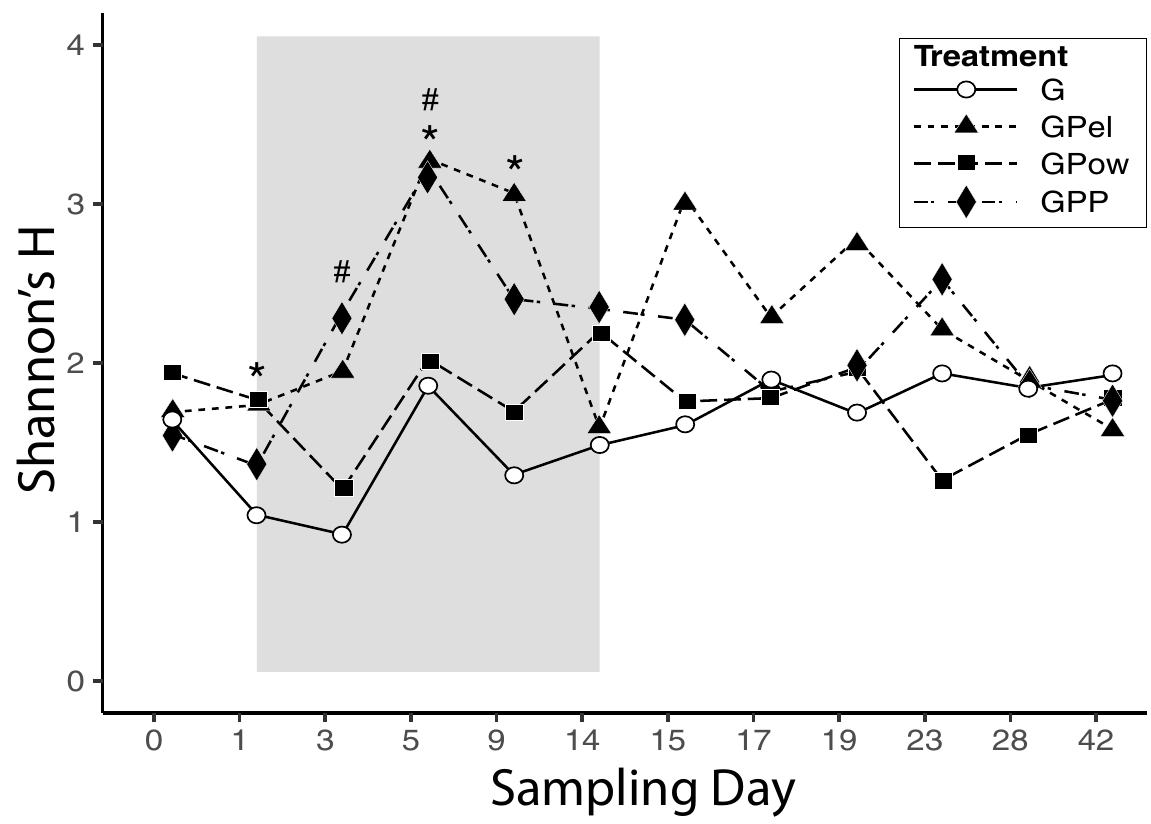
Fig 4. Bacterial diversity (Shannon Diversity Index) in fecal samples collected over 42 days from domesticated pigeons exposed to different diets. Shaded area represents treatment period, and treatments consisted of Grain (G), Grain + Probiotic Powder (GPow), Grain + Probiotic Pellet (GPel), and Grain + Probiotic Pellet + Probiotic Powder (GPP). Asterisks ( � ) represent a significant difference of the GPel treatment from the Grain (G) treatment, and pound signs (#) represent a significant difference of the GPP treatment from the Grain (G) treatment at α = 0.05.